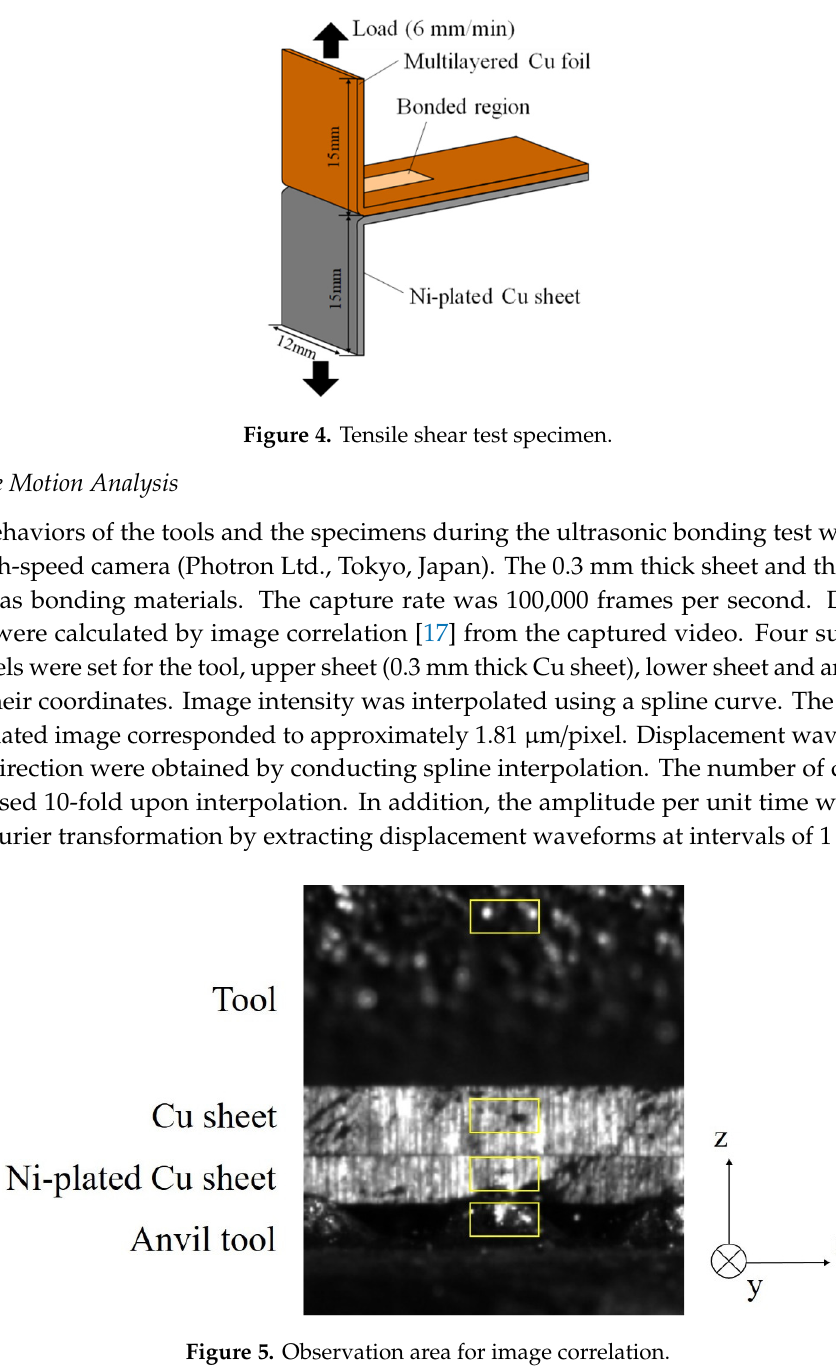
Figure 5. Observation area for image correlation.